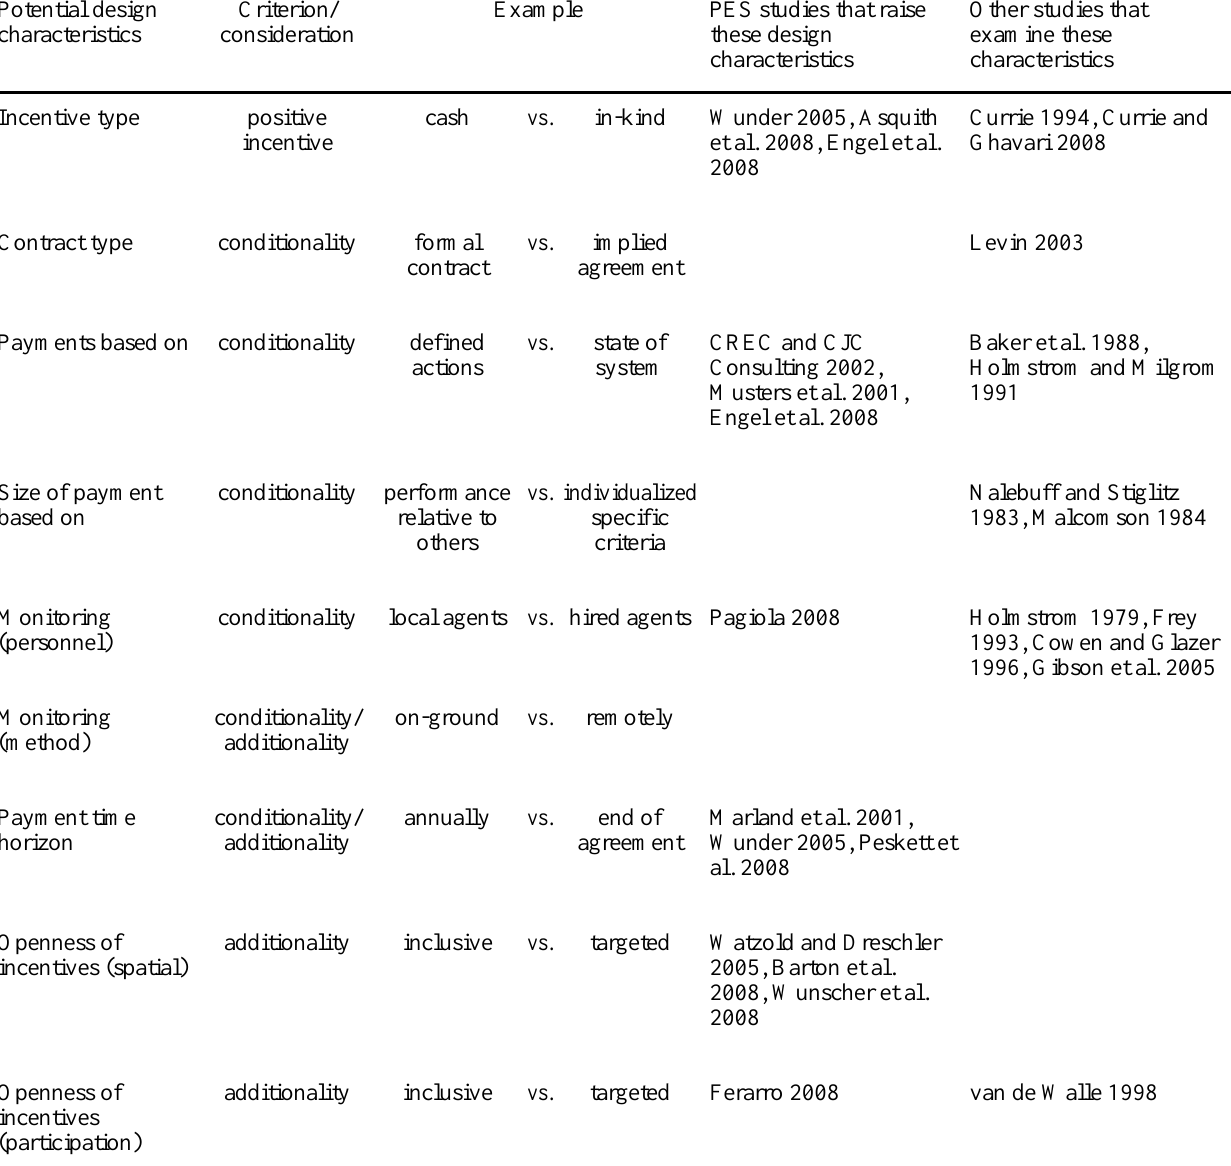
Table 3. Examples of some aspects of PES design that may be modified in order to address local institutional